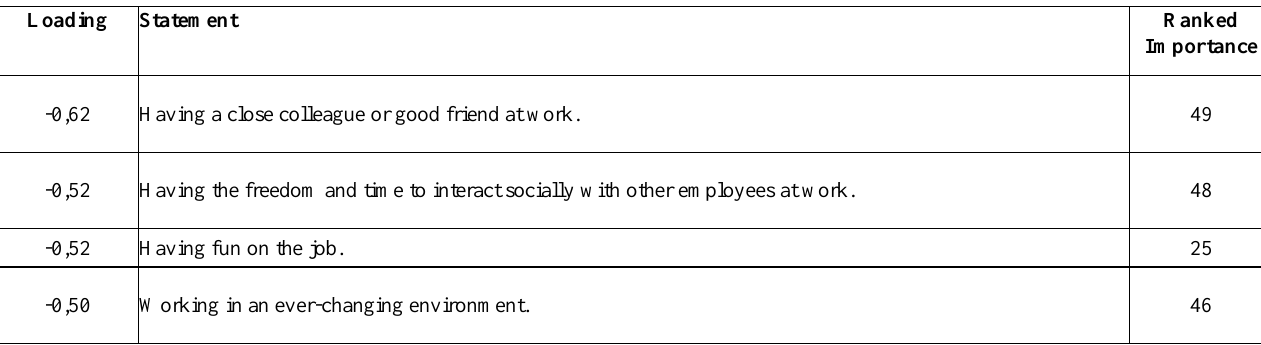
Table 8: Variables associated with factor six